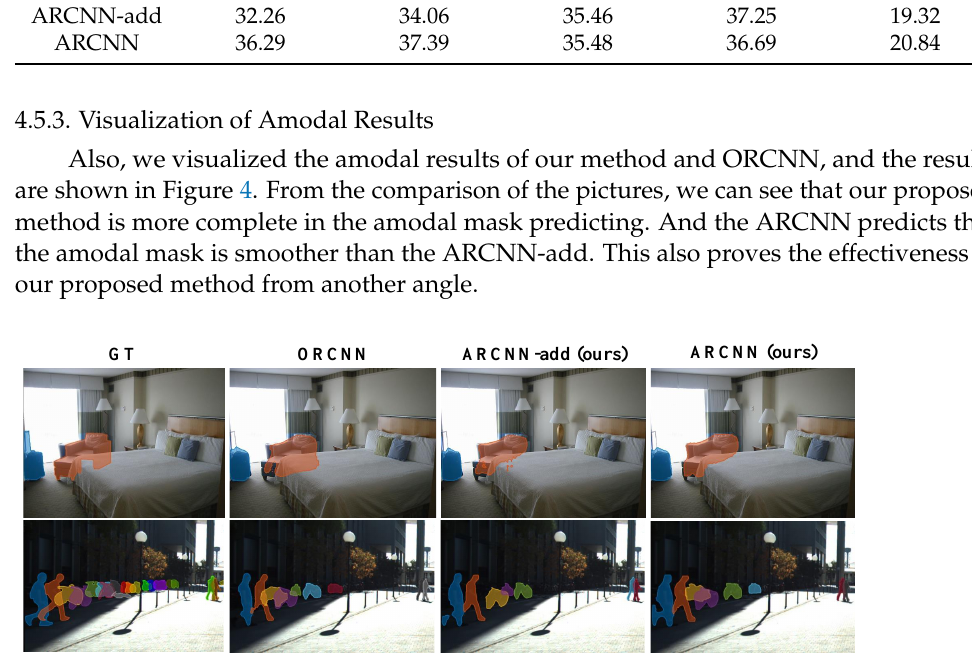
Figure 4. The columns from left to right are the ground-truth amodal masks, prediction of ORCNN and Ours, respectively. The first row is the result from COCOA cls dataset. And the other row is from KINS